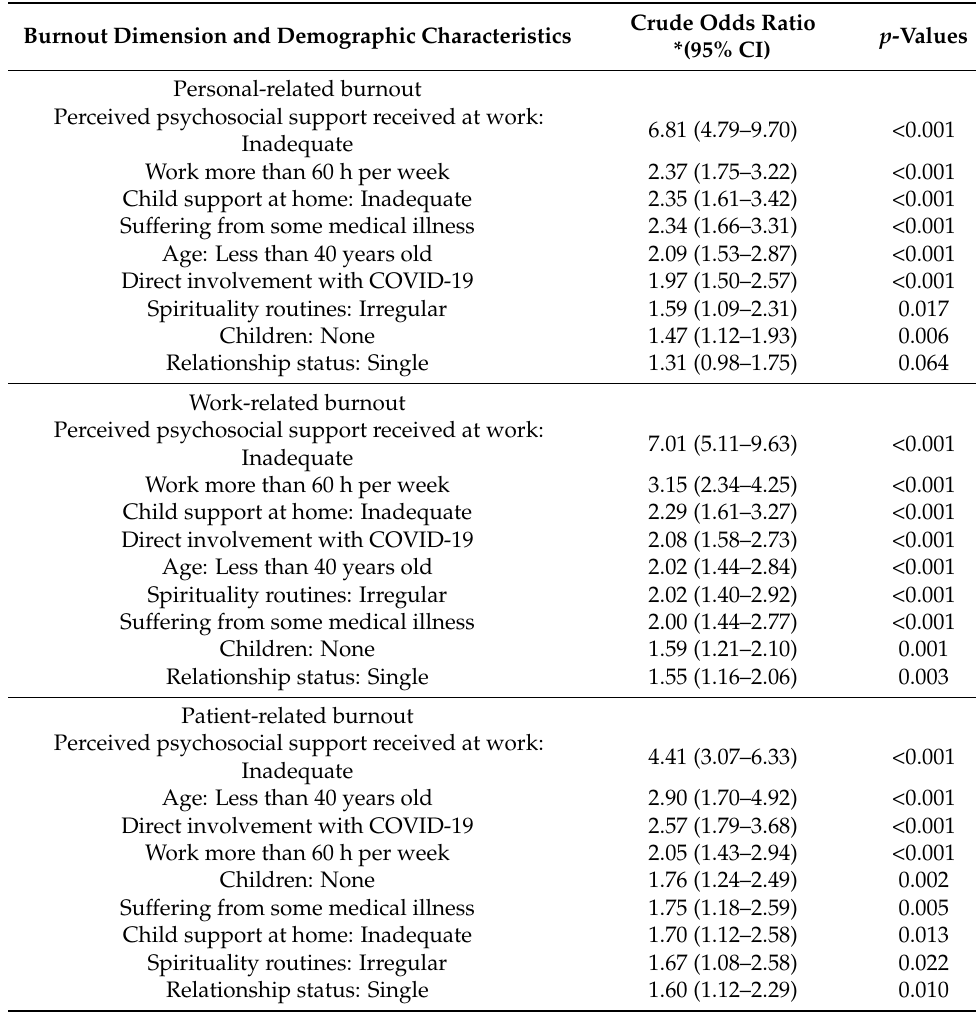
Table 3. Significant associations between the demographic characteristics and burnout using simple logistic regression ( n =